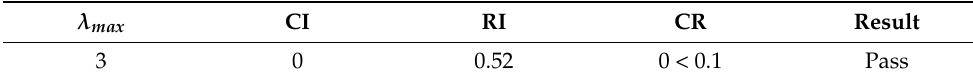
Table 6. Consistency inspection results for